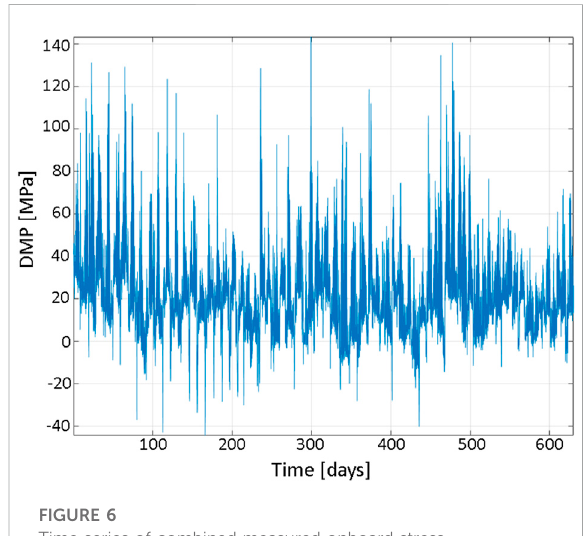
FIGURE 6 Time series of combined measured onboard stress.